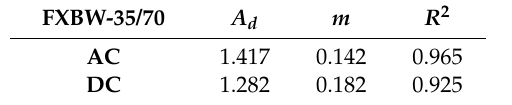
Table 7. Fitting values of A d , m and R 2 according to the test results in Table 6 with Equation